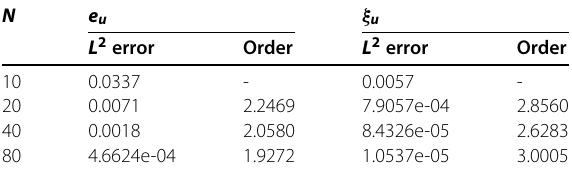
Table 3 The numerical results of the LDG method with the piecewise P 1 space at the final time T = 1 N e u ξ u L 2 error